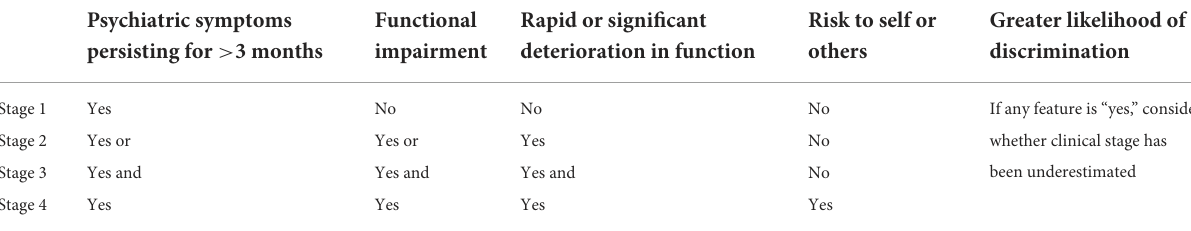
TABLE 1 A Developmental Clinical Staging Model—preliminary structure for further discussion. Psychiatric symptoms persisting for > 3 months